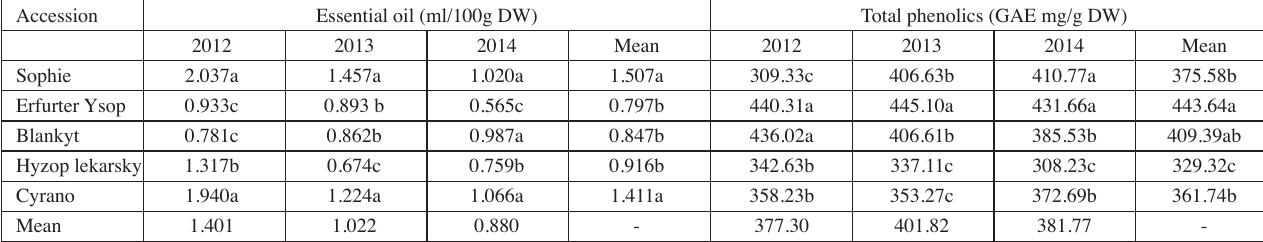
Tab. 4: Yield of essential oil and total phenolic content for the examined accessions during three vegetation years (mean values)